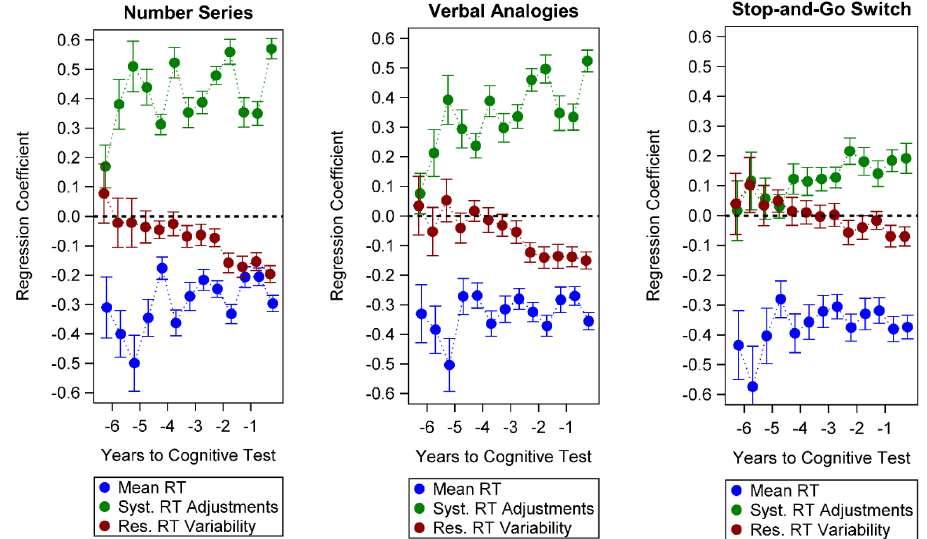
Figure 2. Standardized regression coefficients for the prediction of cognitive test scores from time-lagged survey item response time (RT) components derived from the expanded location-scale model. Error bars represent 95% confidence intervals. Syst. = systematic; Res. = residual.